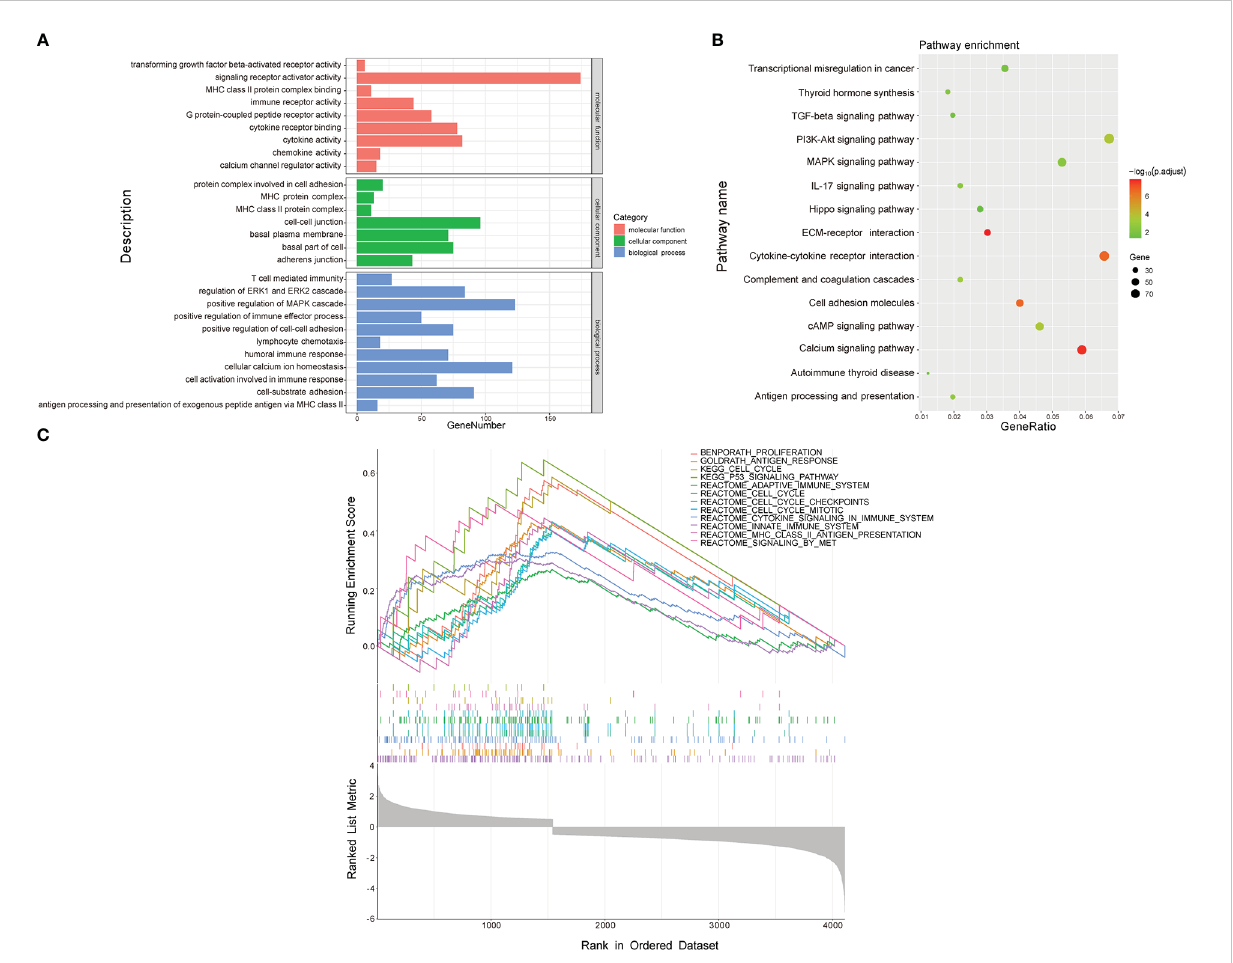
FIGURE 6 Functional enrichment analysis of DEGs between low- and high-risk groups. (A) GO analysis. (B) KEGG pathway analysis. (C)